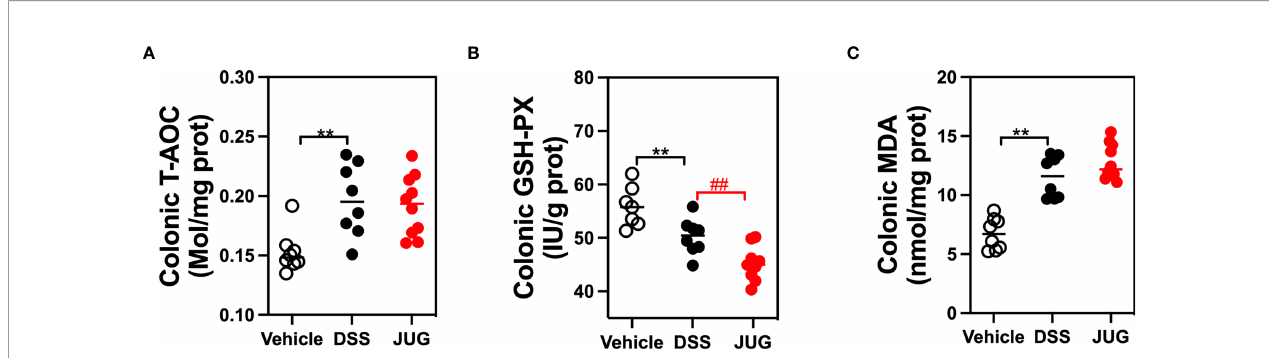
FIGURE 4 | Immunohistochemical examination for analysis of the DSS-induced oxidative damage. The colonic T-AOC (A) , MDA (B) , and GSH-Px (C) were analyzed by immunohistochemical examination. ** P < 0.01, ## P < 0.01.